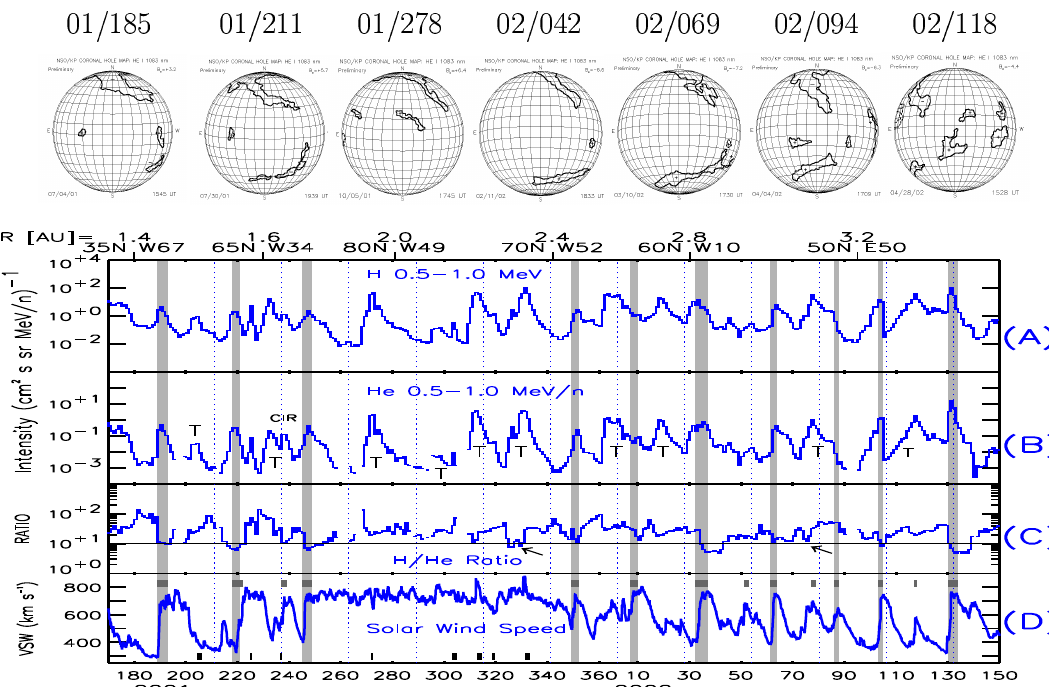
Fig. 2. Upper panel: Coronal hole 1083 nm maps provided by the National Solar Observatory at Kitt Peak taken on the day indicated at the top. The photospheric magnetic polarity of the northern hole is negative. Bottom panel: (A) Daily averages of the 0.5–1.0 MeV proton intensities and (B) daily averages of the 0.5–1.0 MeV/nucleon helium intensities as measured by the HI-SCALE instrument (Lanzerotti et al., 1992); (C) H/He ratio between the daily averages intensity of H and He shown in panels (A) and (B). (D) Hourly averages of the solar wind speed as measured by the SWOOPS instrument (Bame et al., 1992). Time interval extends from 19 June 2001 (day 170) to 30 May 2002 (day 150). Gray shadow bars identify the passages of recurrent CIRs over Ulysses. Upper gray rectangles in the solar wind panel (D) show the arrival of compression regions formed by the interaction between solar wind of different speeds. Black rectangles at the bottom of the solar wind panel (D) indicate CMEs as identified by counterstreaming halo electron events in the solar wind. Note that CME identification was done until the end of 2001. Vertical dotted lines are spaced every 26 days. Transient events are indicated by T